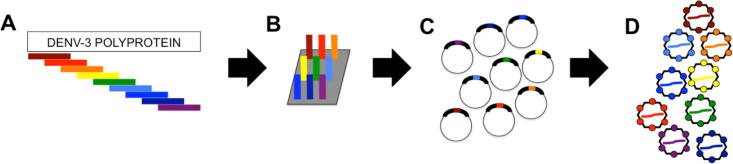
Generation of MS2-VLP DENV-3 antigen fragment library.(A) The DENV-3 polyprotein was used to identify all possible 10 amino acid peptides, overlapping by 9 amino acids. (B) E. coli codon optimized coding sequences were synthesized by a massively parallel microchip-based synthesis-on-chip technique (LC Sciences), and (C) then used to generate a corresponding plasmid library in the pDSP62 vector. (D) The library was then expressed as VLPs in E. coli and used in subsequent deep sequence-coupled biopanning experiments.